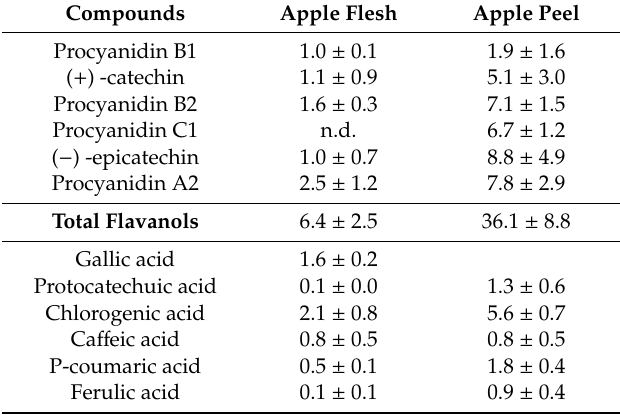
Table 3. Average content of phenolic compounds in apple flesh and peel (single compounds and total concentrations are expressed in mg / 100 g freeze-dried material, TPC denotes total phenolic compounds and is expressed in mg GAE / 100 g freeze-dried material) [11]. “n.d.” denotes “not detected”, “GAE” denotes “Gallic Acid